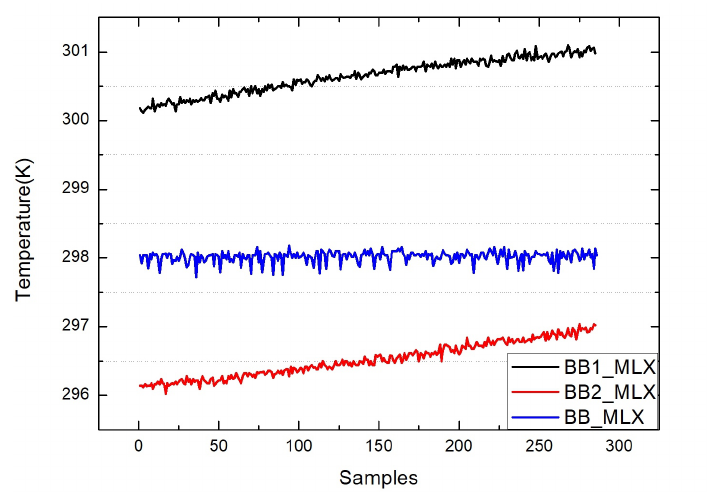
Figure 5. Measurement results of an MLX90614 infrared thermometer directly aimed at a high- temperature blackbody (BB1_MLX), ambient-temperature blackbody (BB2_MLX), and standard blackbody